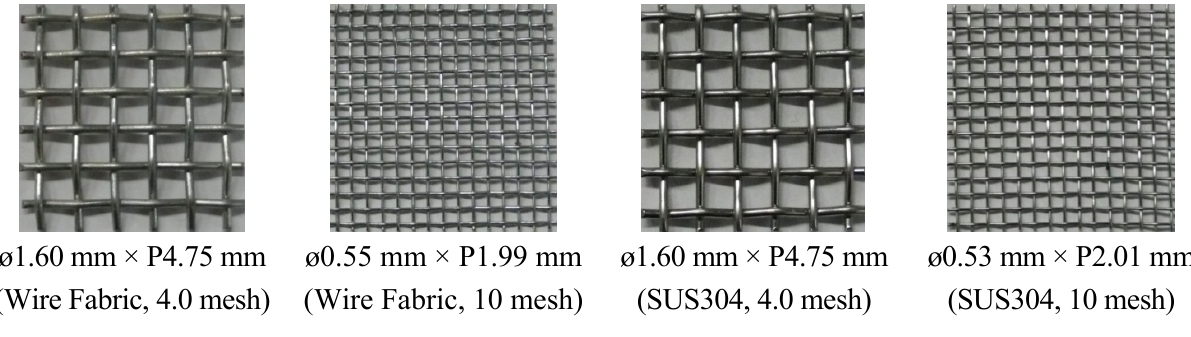
Figure 3. Wire fabric and stainless